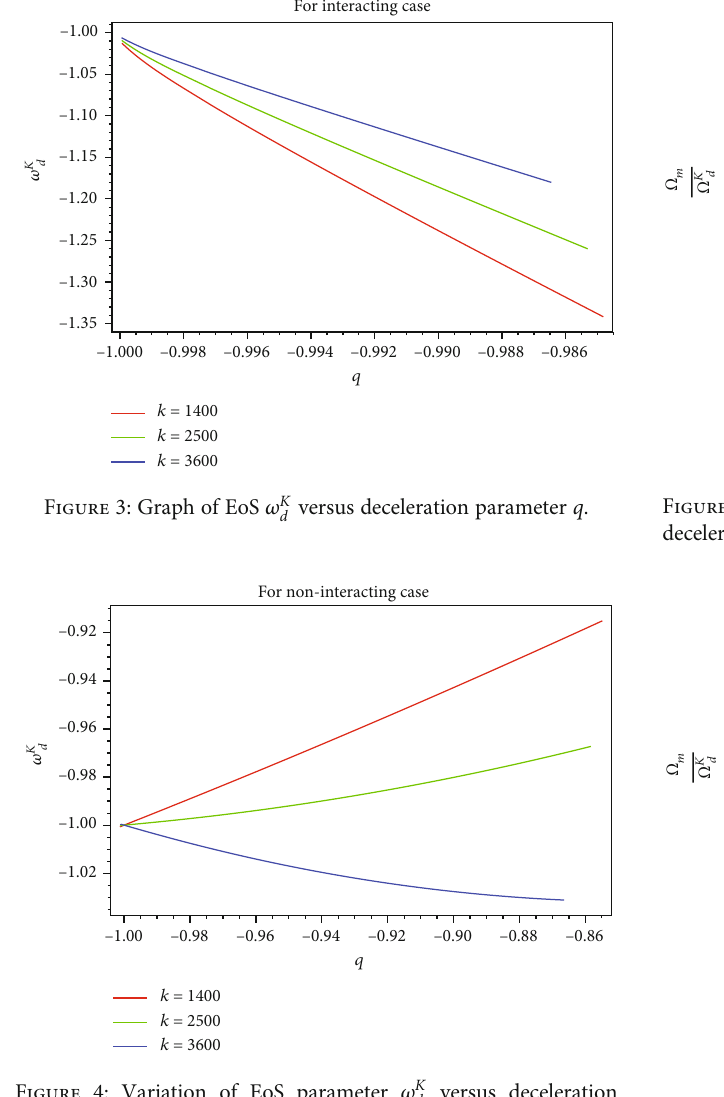
versus deceleration d